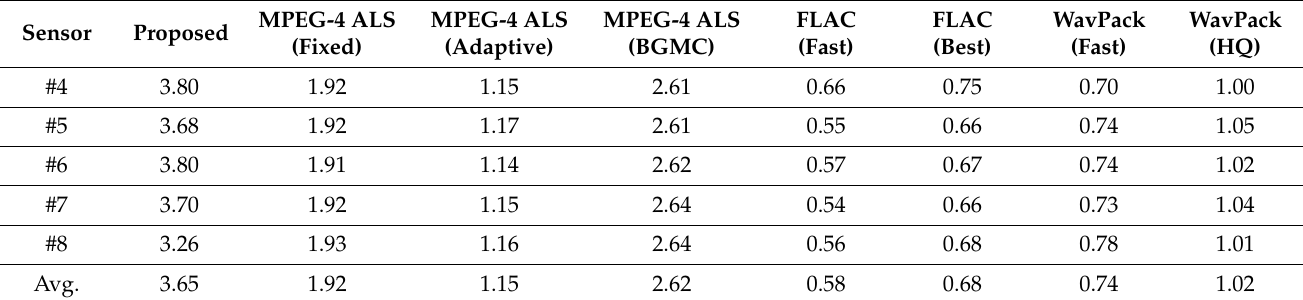
Table 4. Comparison of the encoding processing time(s) of the proposed method with other codecs.